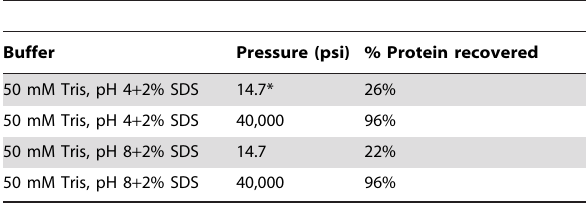
Table 1. Effect of pressure on the recovery of total protein from FFPE tissue